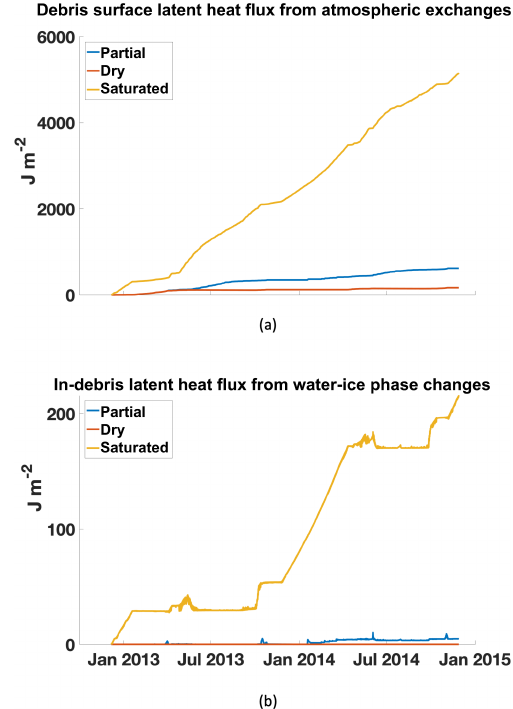
Figure 10. Debris layer moisture by phase in (a) the partially satu- rated ISBA-DEB and (b) the fully saturated ISBA-DEB scenarios. As shown in (b) , the fully saturated debris is water-filled (having a lower thermal diffusivity than dry debris) during the summers when debris surface temperatures lead to glacier melt. The difference in moisture in the debris surface layer accounts for the different sur- face latent heat fluxes (Fig. 11). We refer the interested reader to the 2013 JJAS mean diurnal water and ice contents (Fig. S4).